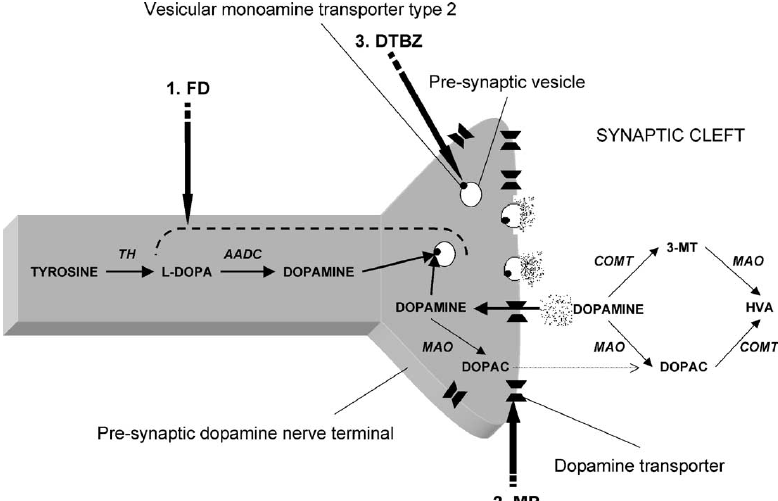
Figure 1. PET Imaging Tools Used in PD. Schematic representation of dopamine synthesis and metabolism, including sites of action of pre-synaptic dopaminergic PET